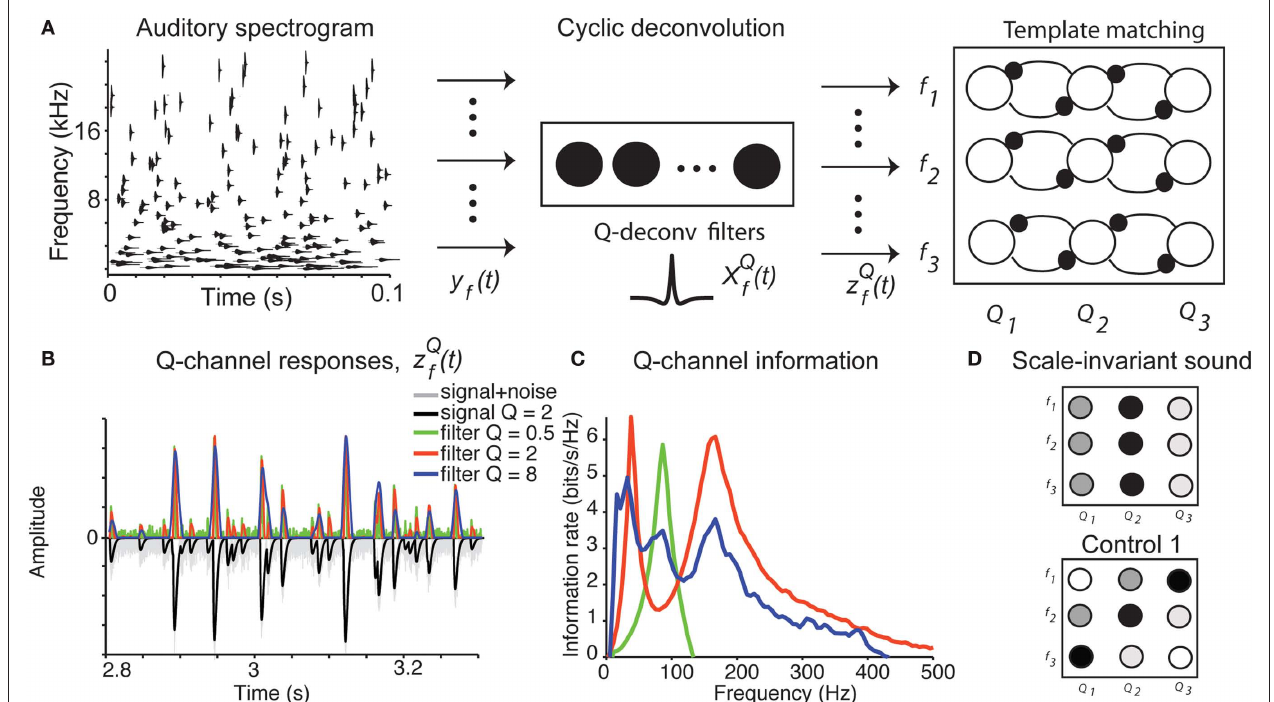
FIgure 6 | Cyclo-spectral template matching model. (A) An overview of the model. The incoming sound waveform is transformed into a spectro-temporal representation at the early auditory stages. In stage 1, the signal within each spectral channel is passed through a filterback of deconvolution filters of varying Q , X t fQ ( ), constructed as two-sides derivatives of the gammatone function. In the last stage, through lateral inhibition, the most active Q based channel is enhanced and averaged over time. (B) The output of the stage 2 of the model of an input signal (black trace, inverted for clarity of figure) with f = 1000 Hz, Q = 2, rate 1 with 10% Gaussian noise (gray trace, inverted for clarity of figure) for X t fQ ( ), with Q = 0.5 (green trace), 2 (red trace), and 8 (blue trace). The convolution of the input and X t fQ ( ) was normalized by the maximum value and half-wave rectified. The output for the filter with Q = 2 captures all the peaks present in the original signal, while the output for the filter with Q = 8 smoothes over